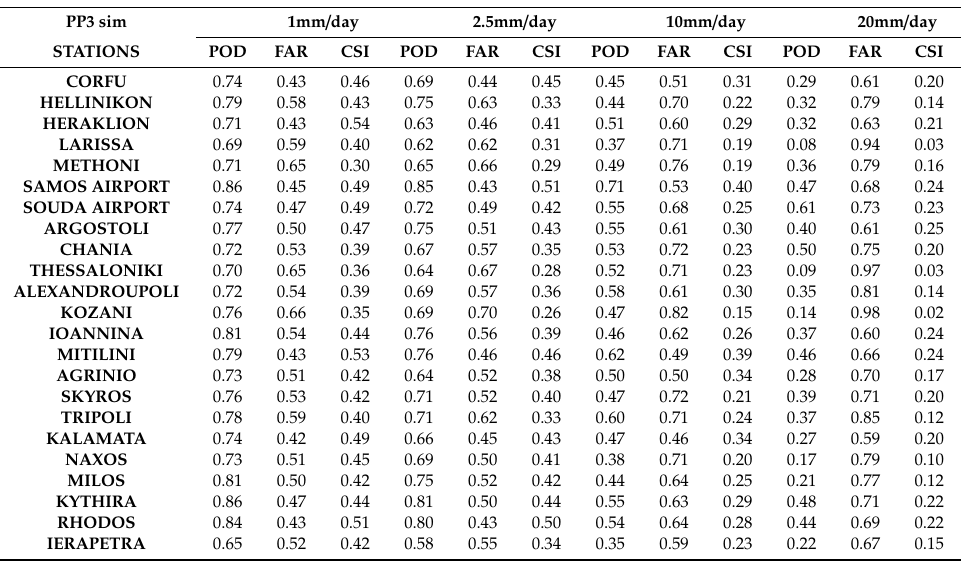
Table 5. Probability of detection (POD), false alarm ratio (FAR) and critical success index (CSI), are based on the contingency table, described on Table 3, for four thresholds calculated for each station separately, only for